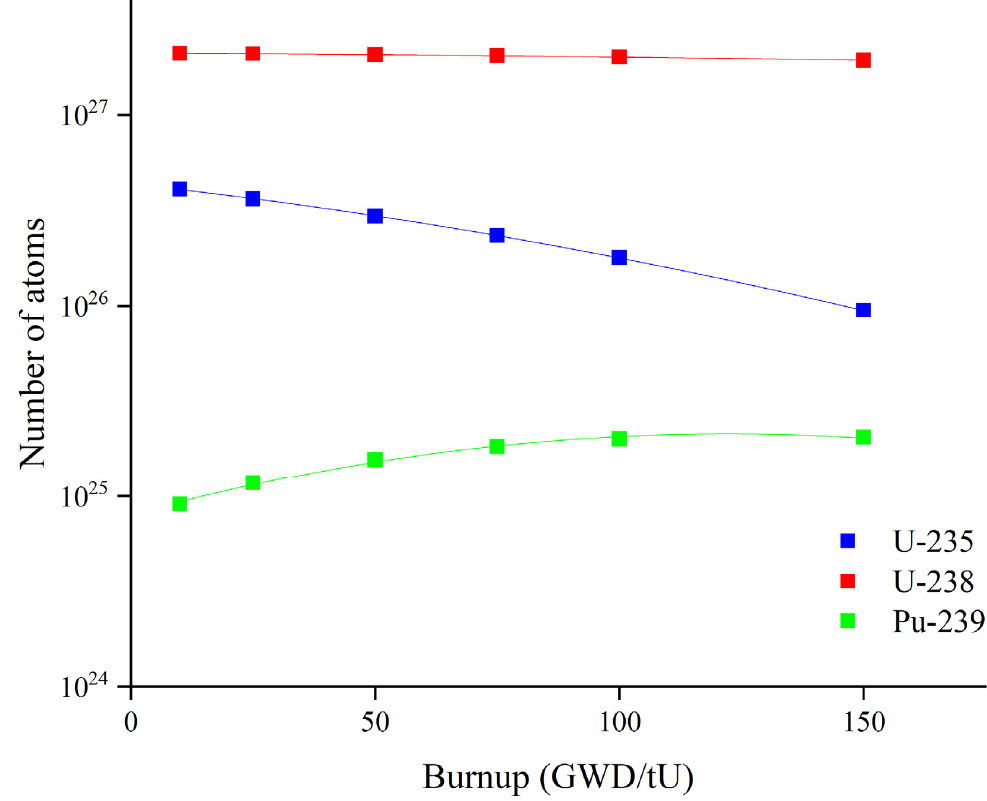
Figure 7. Number of fissionable atoms ( 235 U, 238 U, and 239 Pu) versus burnup.